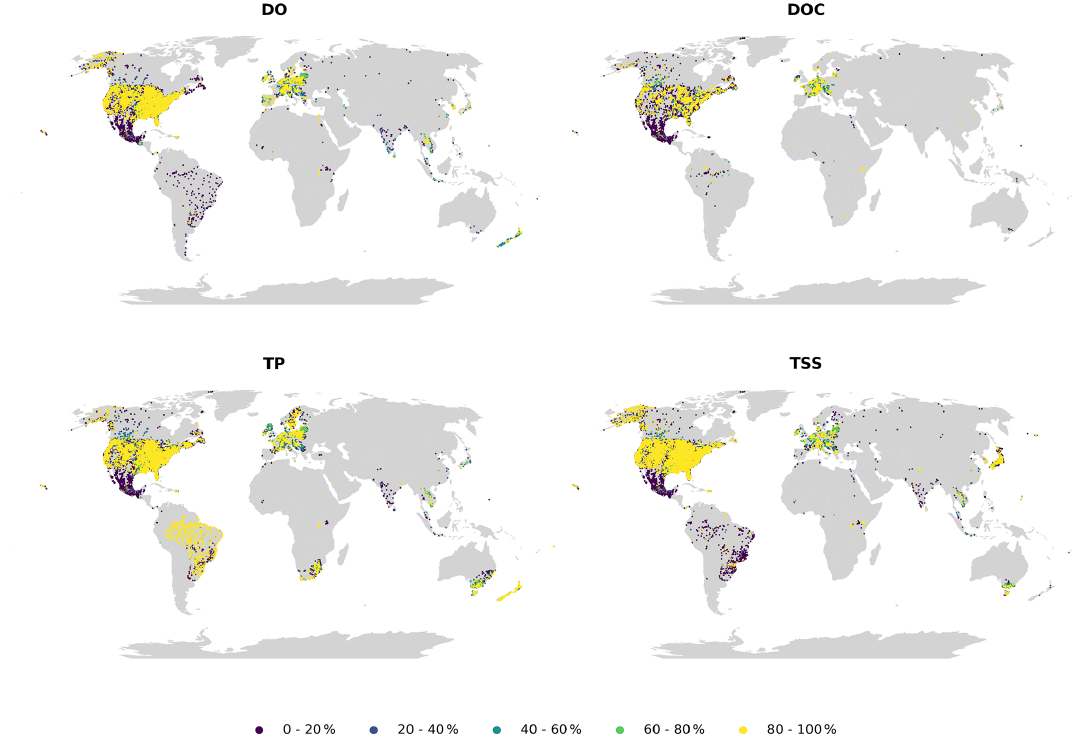
Figure 6. Monthly continuity for dissolved oxygen (DO), dissolved organic carbon (DOC), total phosphorus (TP) and total suspended solids (TSSs).